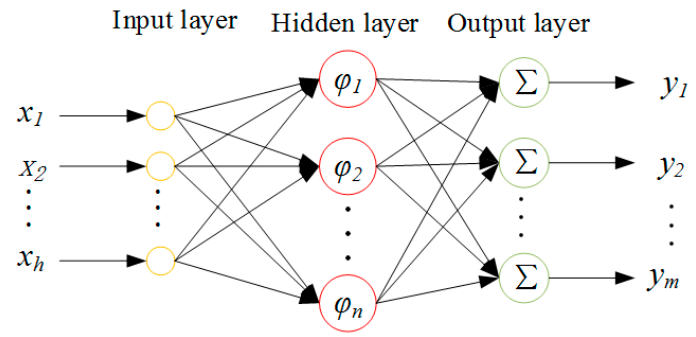
Figure 1. The structure of a radial basis function (RBF) neural network.